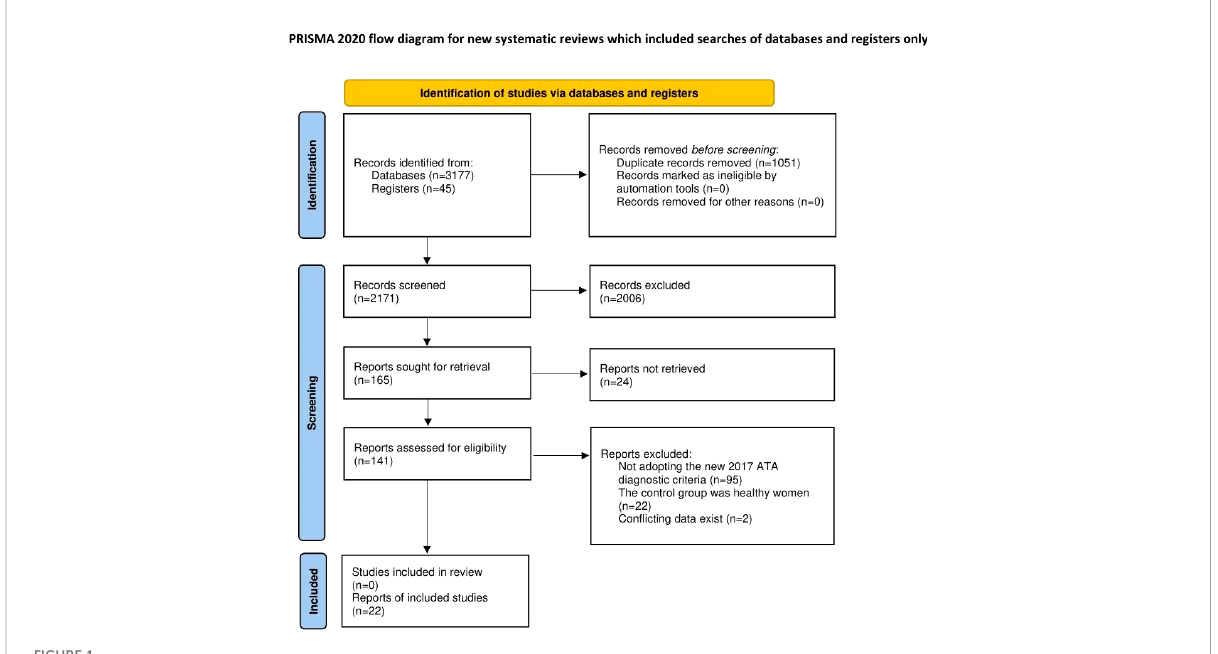
FIGURE 1 Flow diagram of study selection (PRISMA